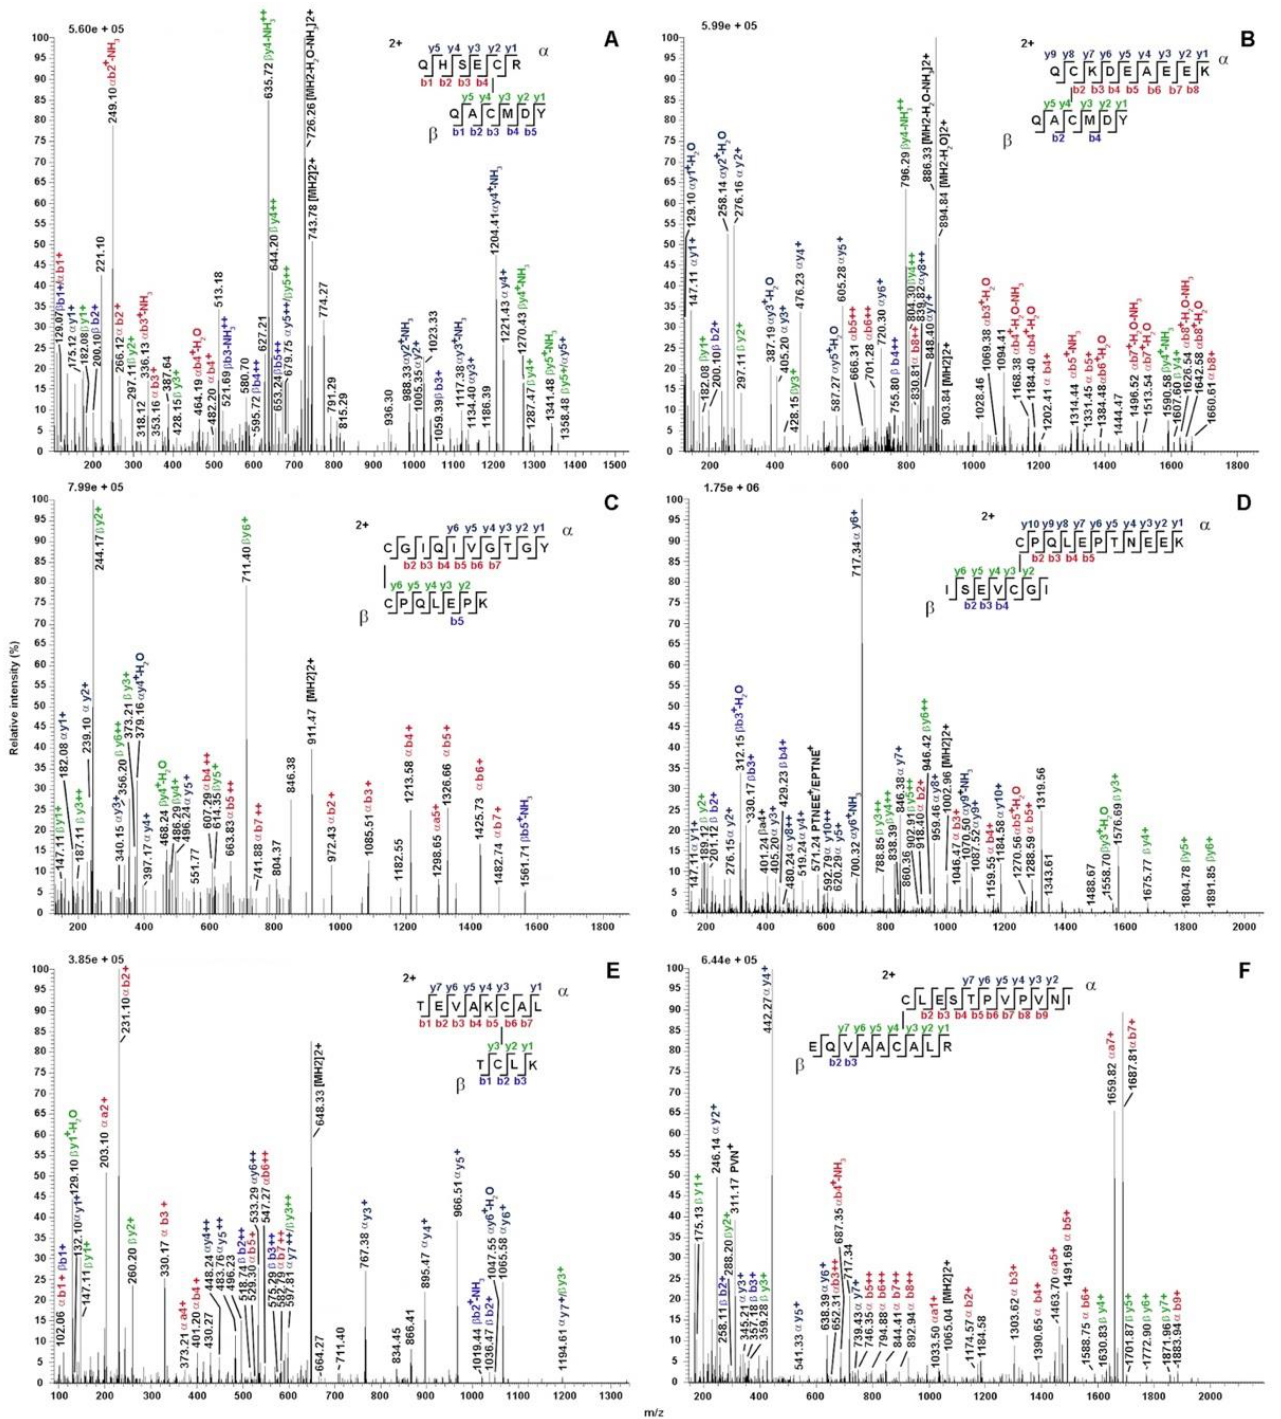
Figure 3. Exemplificative fragmentation spectra of disulfide-bridged peptides identified in the tryptic-chymotryptic digests of TurtOBP1 and TurtOBP2 by nanoLC-ESI-Q-Orbitrap-MS/MS. Panels ( A , C , E ) and ( B , D , F ) report peptides from the TurtOBP1 and TurtOBP2 digests, respectively. The fragments are reported in different color depending on peptide present in S-S-linked species and corresponding b and y ion series. Complete data on disulfide-bridged peptides are reported in Table 1.